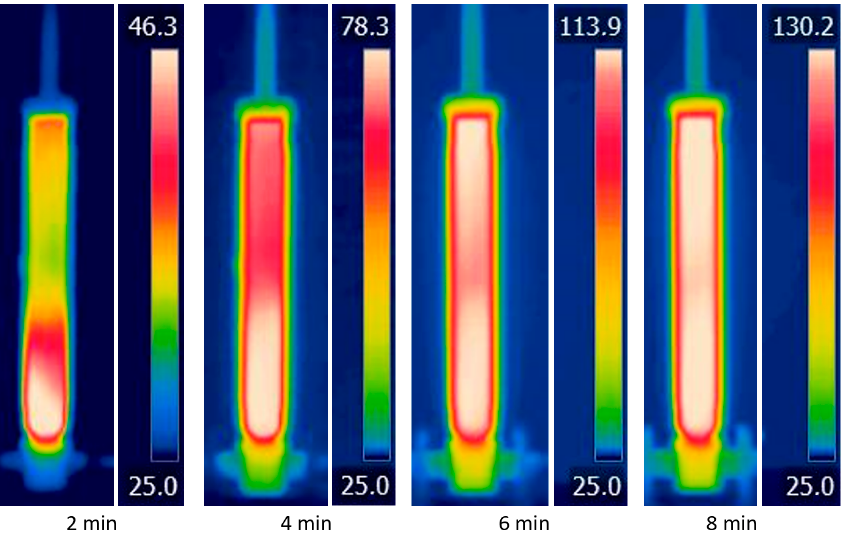
Figure 5. Temperature distributions on the surface of the shock absorber (temperature in (°C)).